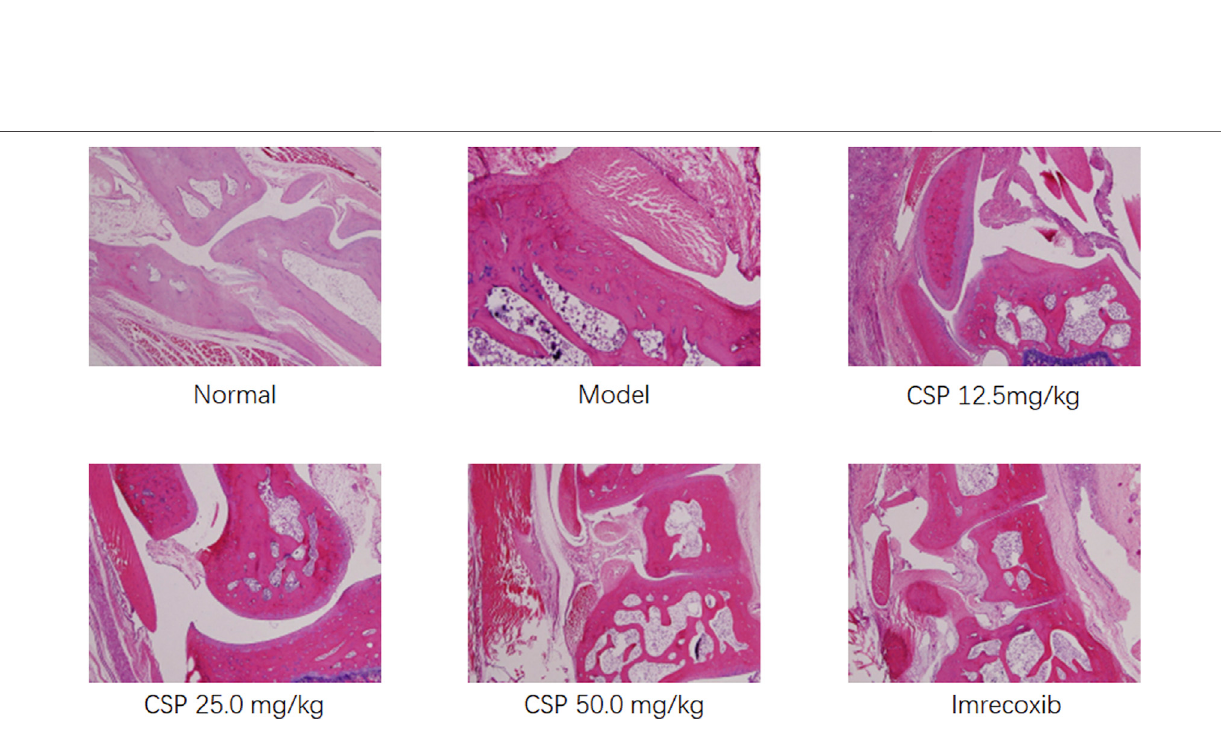
Frontiers in Pharmacology |